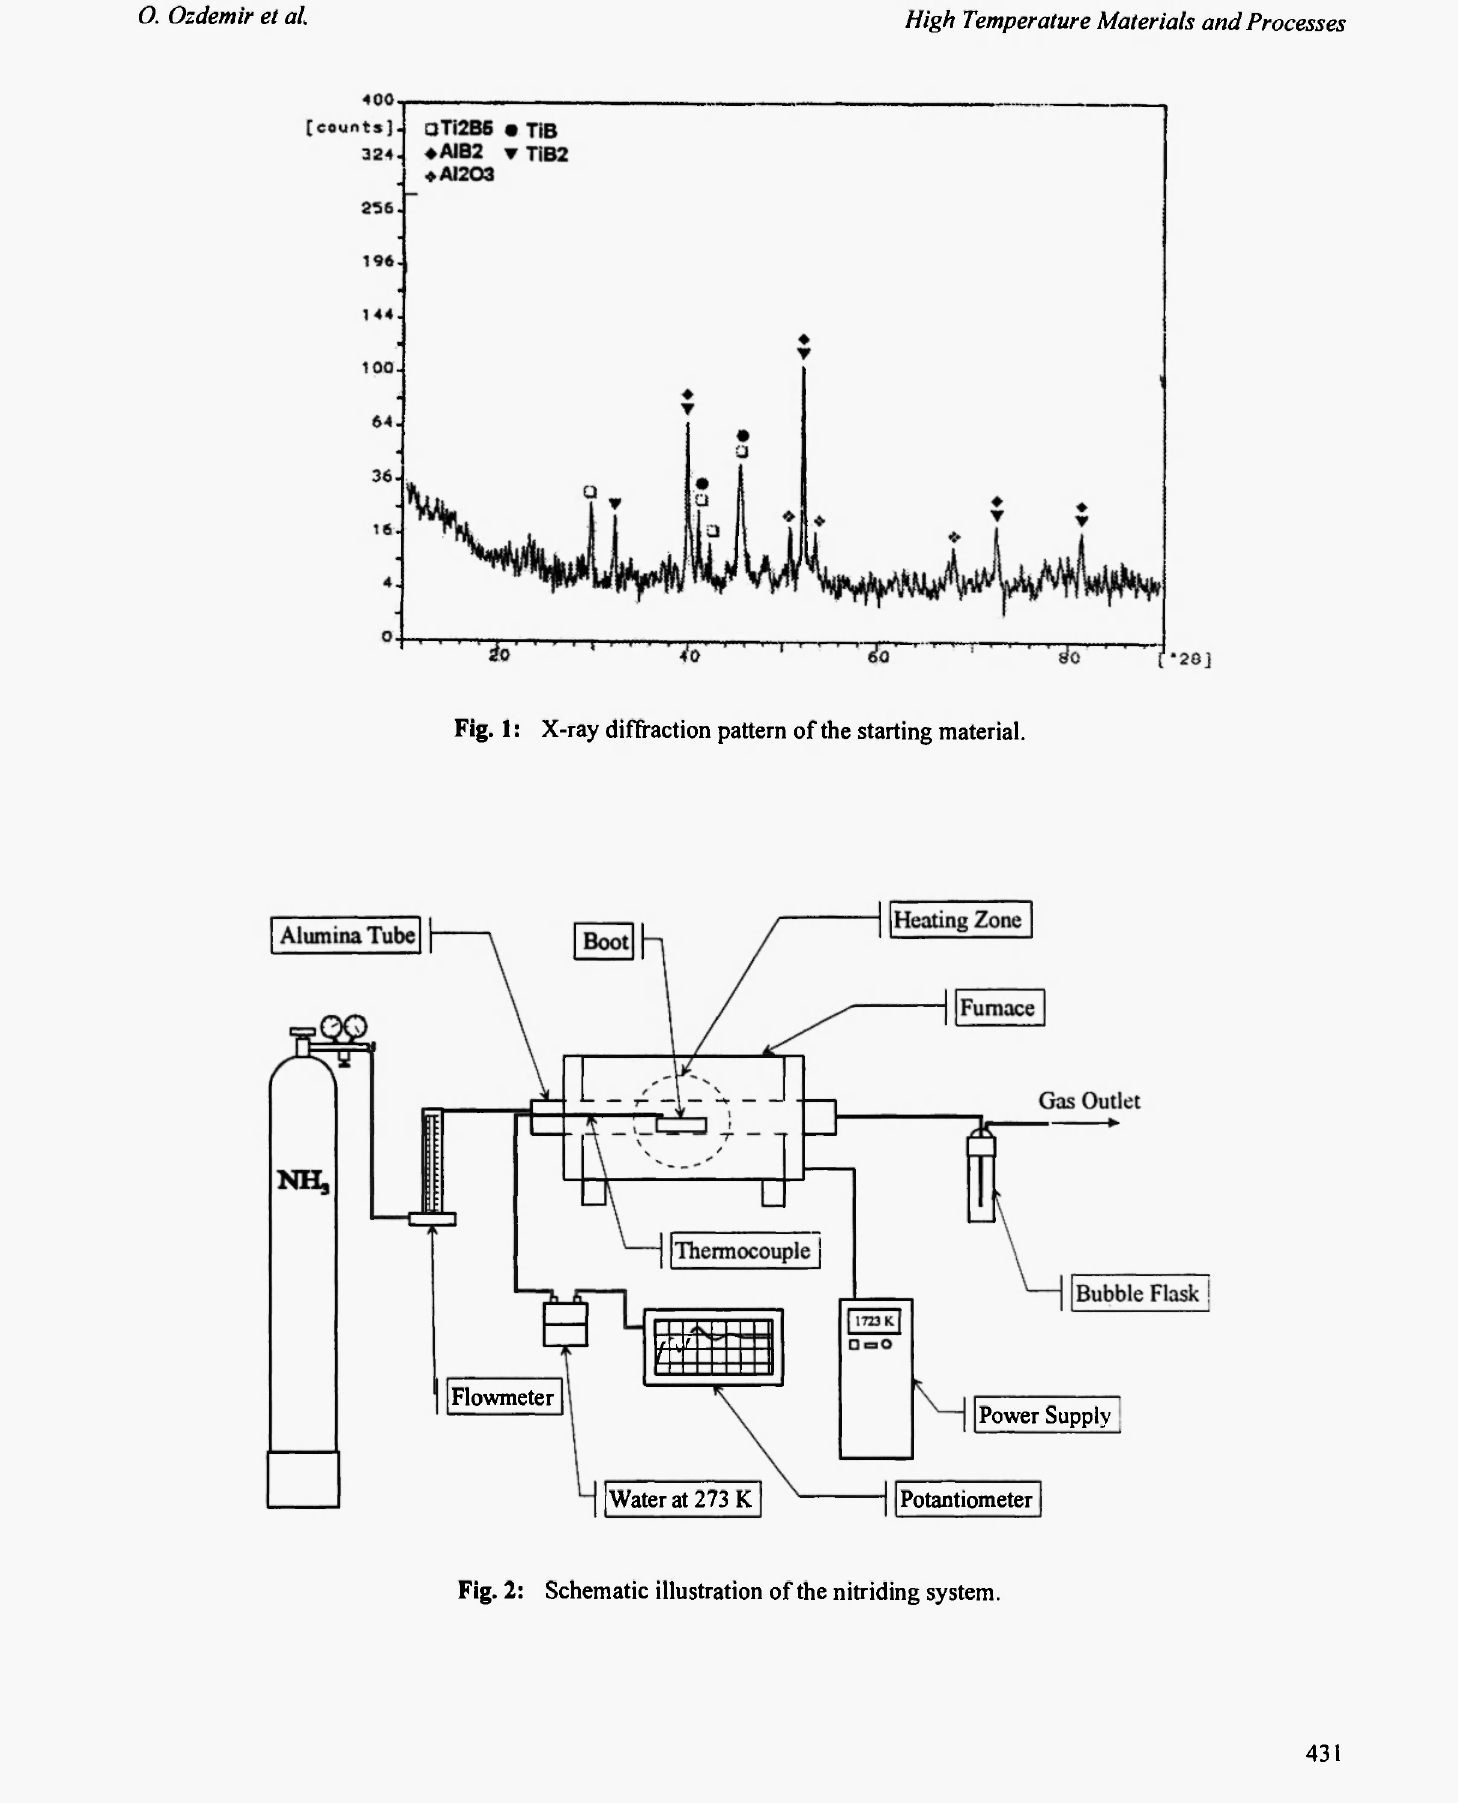
Fig. 2: Schematic illustration of the nitriding